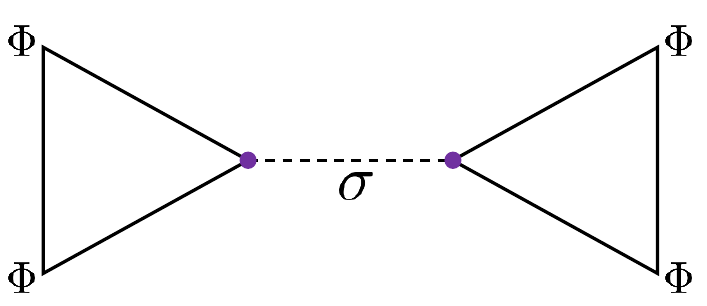
Figure 3 . The two-triangle diagram, given in (3.6), determines the change in the connected correlator h (cid:8)(cid:8)(cid:8)(cid:8) i in the s -channel, to leading order in 1 =N . The total result is a sum of three such diagrams, one from each